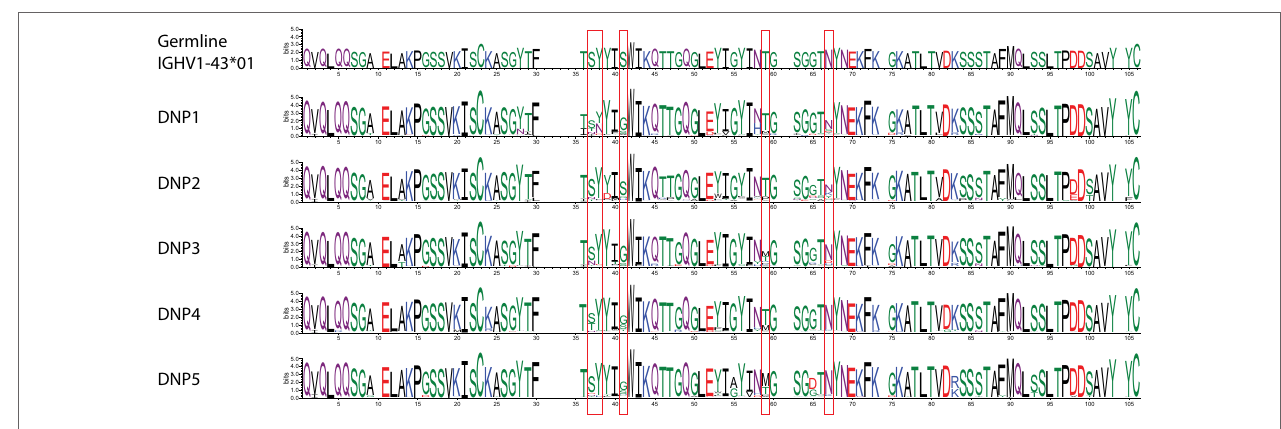
FigUre 7 | Weblogo plots of the sequences contained in the phylogram branch encompassing all nodes highlighted in red in Figure S7 in Supplementary Material. A consensus sequence was extracted from the plots, and the most homologous germline sequence was determined with the DomainGapAlign function provided by IMGT. The sequence of this was included as a similar weblogo in the Figure as a